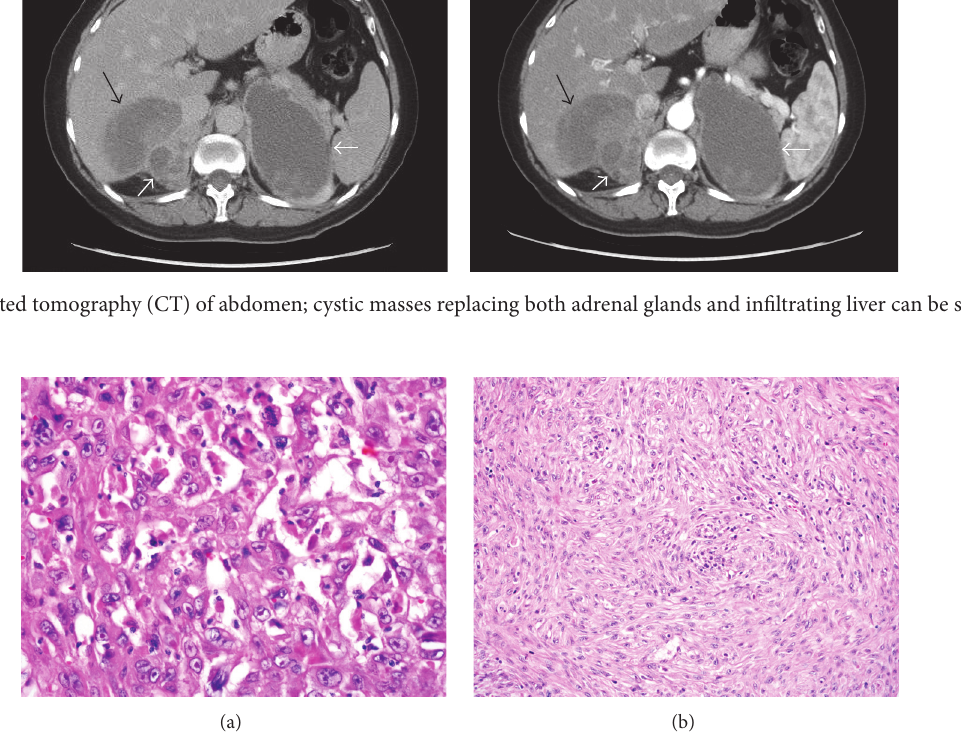
Figure 2: Microscopic findings of the resected tumor. (a) Epithelioid cells display vesicular nucleus and mitosis (H&E × 40), (b) fascicles of spindle cells (H&E ×